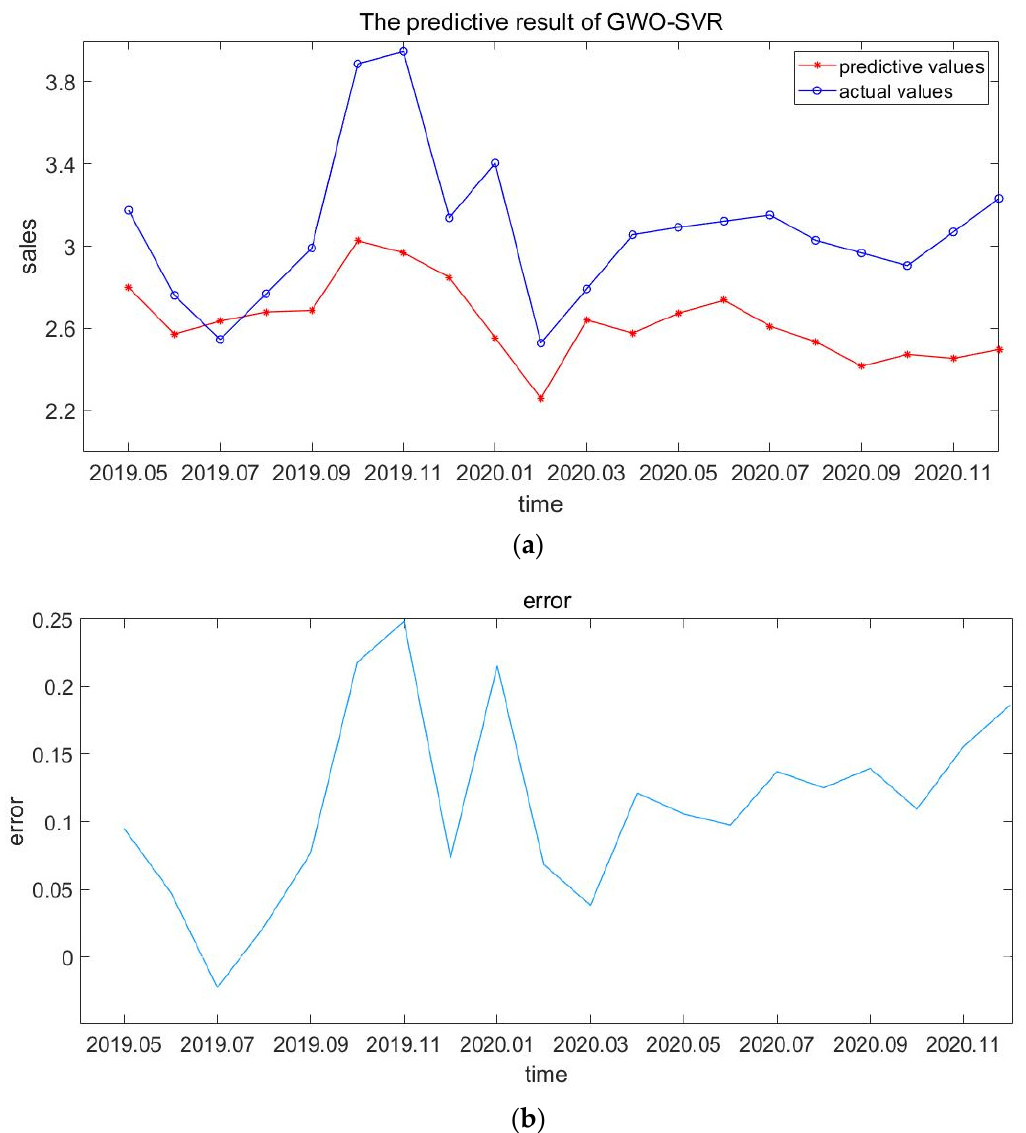
Figure 4. Sales fitting chart and error chart of Kaluola. Figure 4. ( a ) Sales fitting chart and ( b ) error chart of